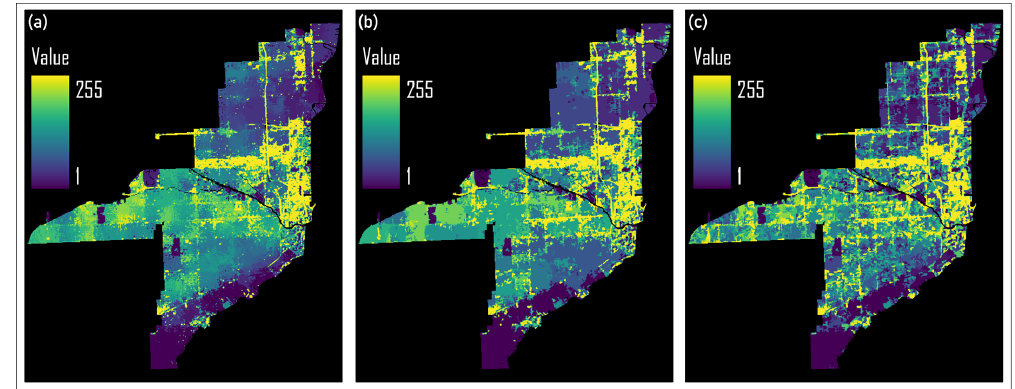
Figure 5. NBI object primitives derived from Landsat 8 OLI 22 October 2016 data; ( a ) small segment size emphasizing surface brightness (spectral detail: 13, spatial detail: 8, minimum segment size in